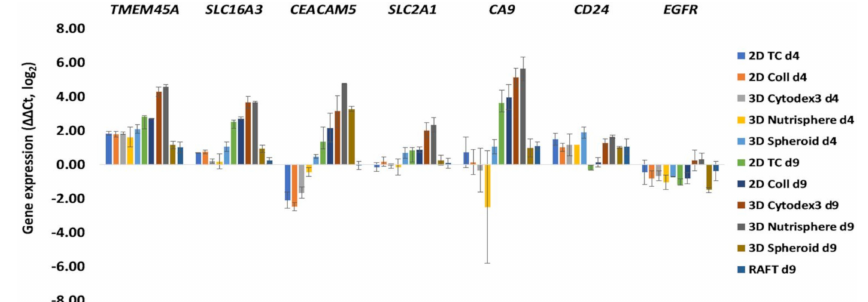
Figure 4. Gene expression changes after 4 (d4) and 9 days (d9) of culture under di ff erent 2D and 3D conditions. Selected genes having cell surface localized protein product and well characterized antibody available on the market: TMEM5A, SLC16A3 (MCT4), CEACAM5, SLC2A1 (GLUT1), and CA9 showed 16–32 times overexpression in 3D Cytodex3 and 3D Nutrisphere compared to 2D monolayer. Data are mean ± SD of three replicates.